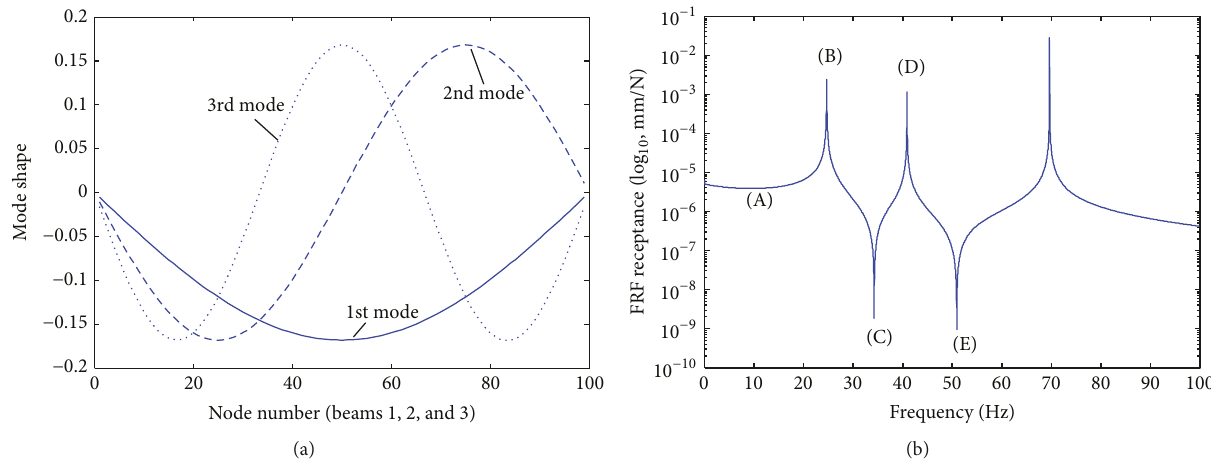
Figure 3: Dynamic characteristics of the system: (a) mode shapes and (b) FRF